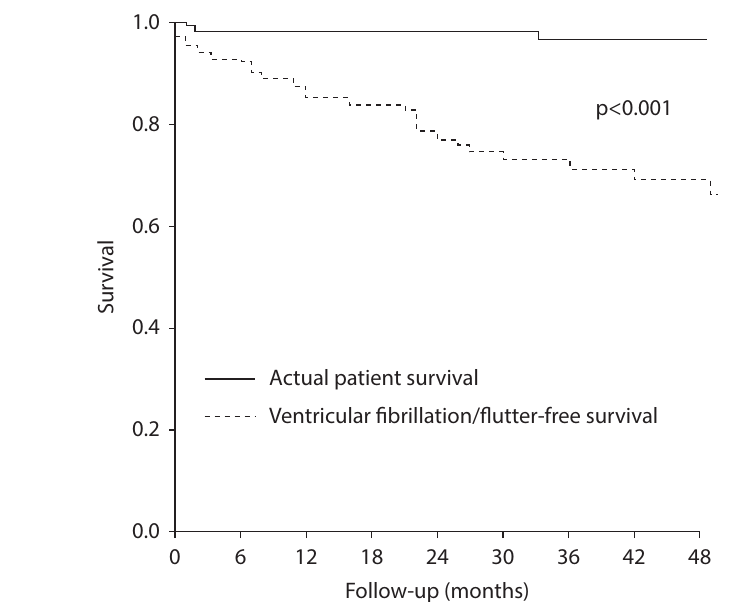
Figure 4. Kaplan-Meier analysis from DARVIN I study of actual patient survival (upper line) compared with survival free of ventricular fibrillation/flutter (lower line) that in all likelihood would have been fatal in the absence of the ICD. The divergence between the lines reflects the estimated mortality reduction by ICD therapy of 24% at 3 years of follow up